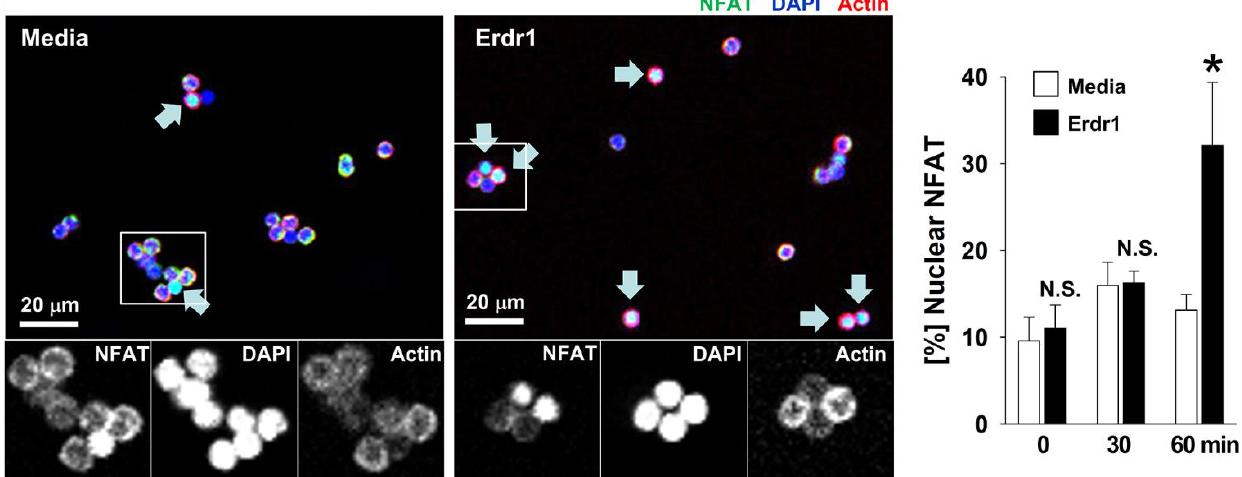
Figure 4. Erdr1 induces translocation of NFAT1 into nuclei in the presence of TCR stimulation.CD4 T cells were isolated from peripheral lymph nodes of mice. The isolated CD4 T cells were cultured in anti-CD3 ε antibody (250 ng/mL)-coated plates in the absence or presence of Erdr1 (1 μ g/mL) for 30 or 60 min. Cells were then fixed, permeabilized, and stained against NFAT1, followed by phalloidin and DAPI stain. NFAT1 translocation into nuclei was visualized by confocal microscopy, and percentages of NFAT1 translocated cells versus total cells were summarized as mean ± SD. Data are representative of three independent experiments. * p < 0.05.